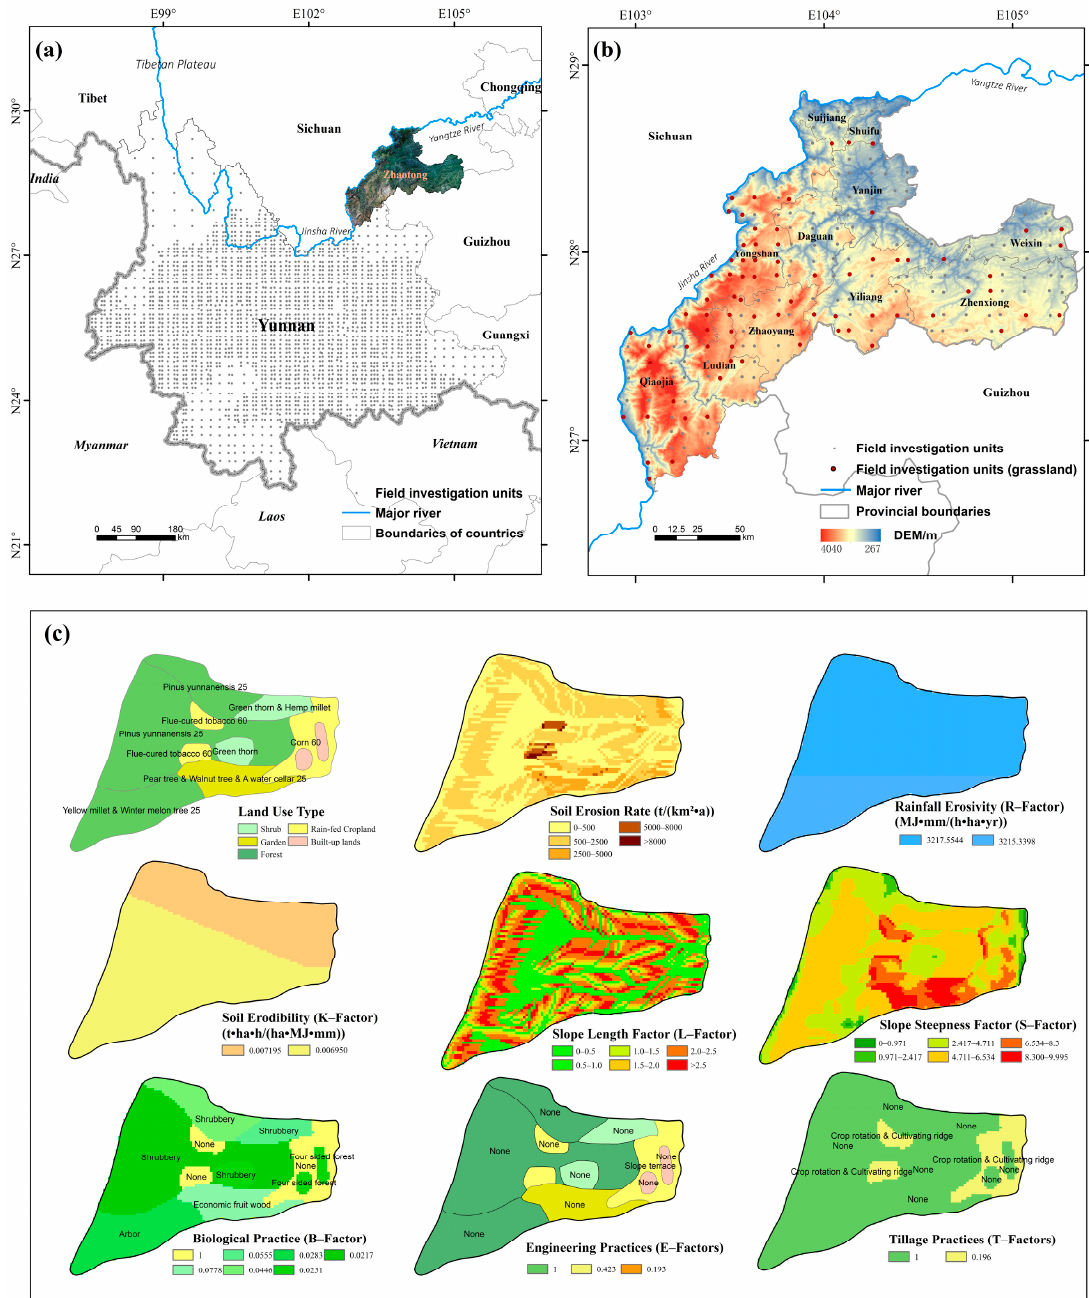
Figure 1. ( a ) Primary sample units (PSUs) allocated in Yunnan with different sampling densities; ( b ) Map of the Zhaotong municipality, showing location, altitude variation and the major river in the region; ( c ) Example of PSUs (PSU No.5332220126).